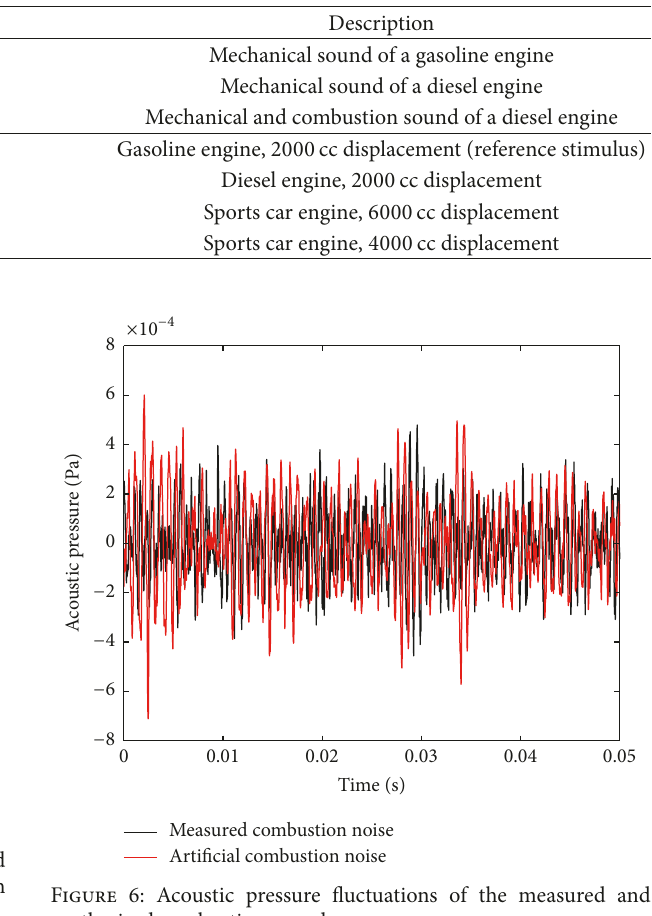
Figure 6: Acoustic pressure fluctuations of the measured and synthesized combustion